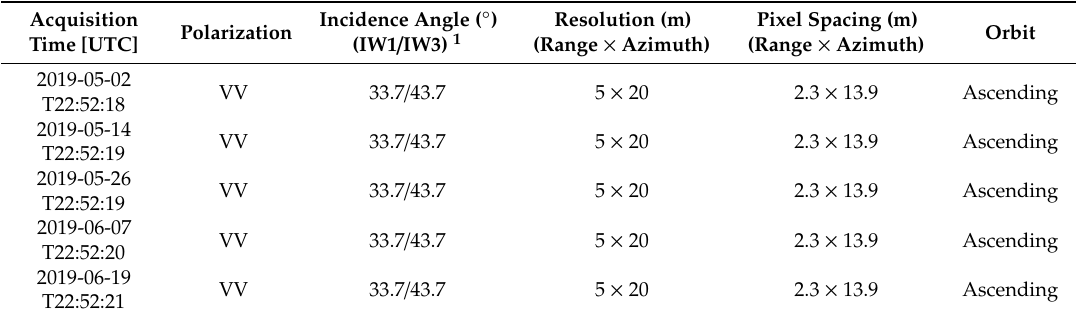
Table 1. S-1 IW image dates for urban flood mapping using CCD, with significant flood events in Gatineau and